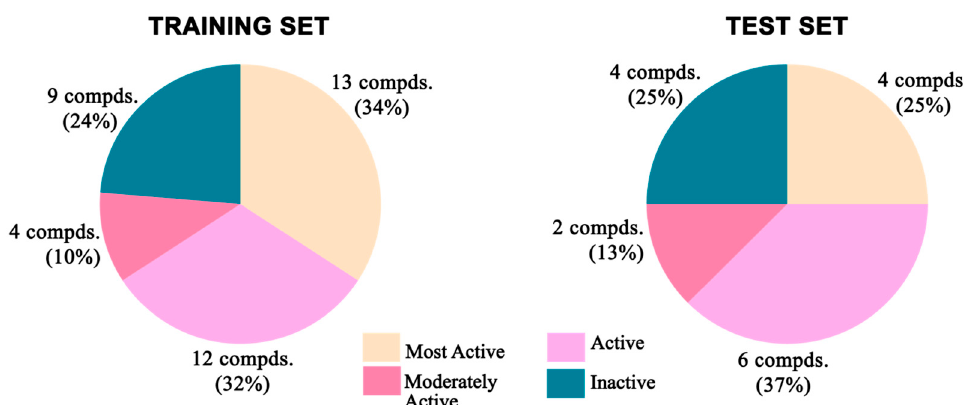
Figure 21. Distribution of different categories of compounds in training and test sets for 2D-QSAR study.